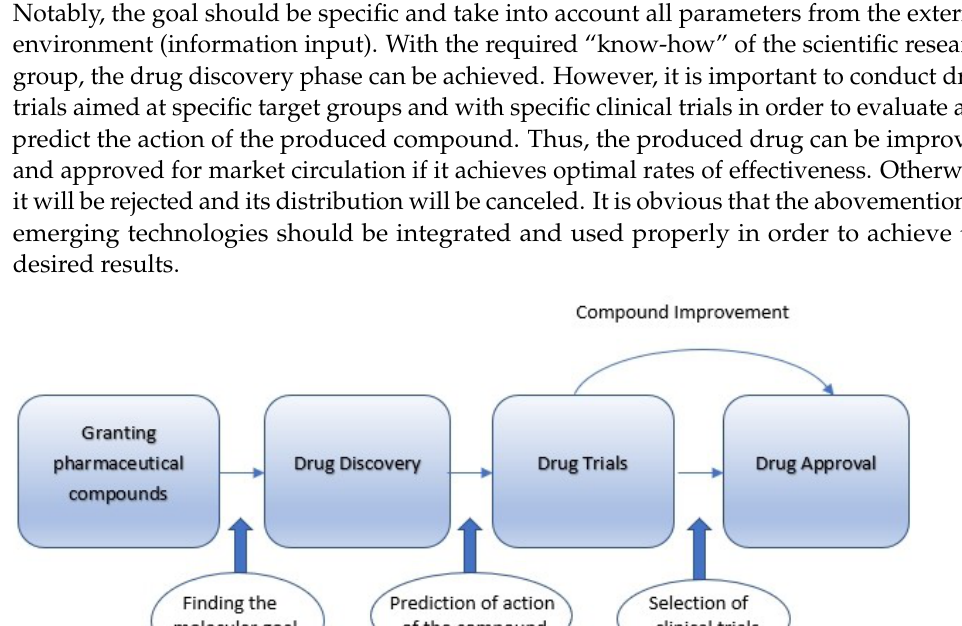
Figure 3. The proposed ML approach for accelerating drug and antibiotic discovery. In supervised learning, the desired output in addition to the inputs is introduced into the neural network. Thus, each network is powered by input and output vectors. In the first stage, the values of the synaptic weights are randomly selected, and for each new input vector, they change until they converge on the real one with the desired network response to the desired level. This difference is defined as an error signal. The signals that reach the output level in case of unwanted convergence are fed backward. For the pur- pose of optimal network training, many vectors are introduced into the input layer. The learning process is completed when the weights do not show significant changes. The inability of the network to solve a problem is addressed by the intervention of the trainer, who reshapes the structure of the network so as to achieve a proper way of operating it. With training, the weights will be stable, during the phase of which the